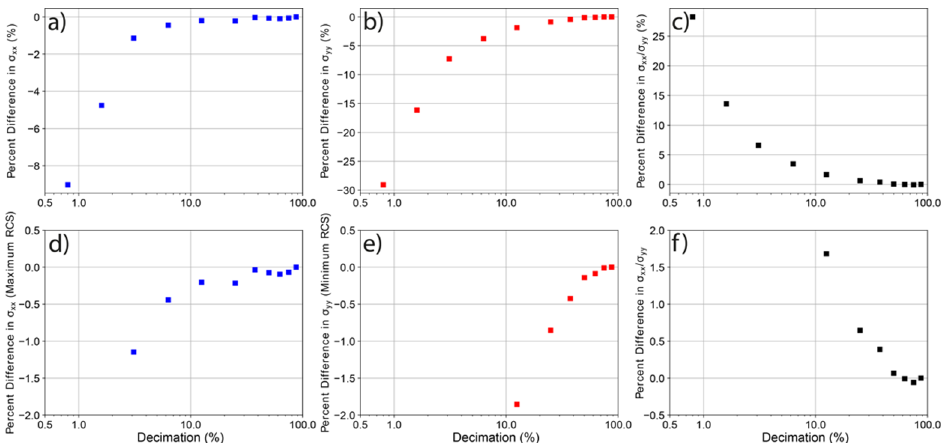
Figure 9. Percentage difference in the modelled ( a ) maximum ( σ xx ) and ( b ) minimum ( σ yy ) RCS val- ues, and ( c ) their ratio ( σ xx / σ yy ), for all decimations compared to the 87.5% model. The top row shows this full range of values ( d – f ) while the bottom row zooms in to show only differences less the 2%.